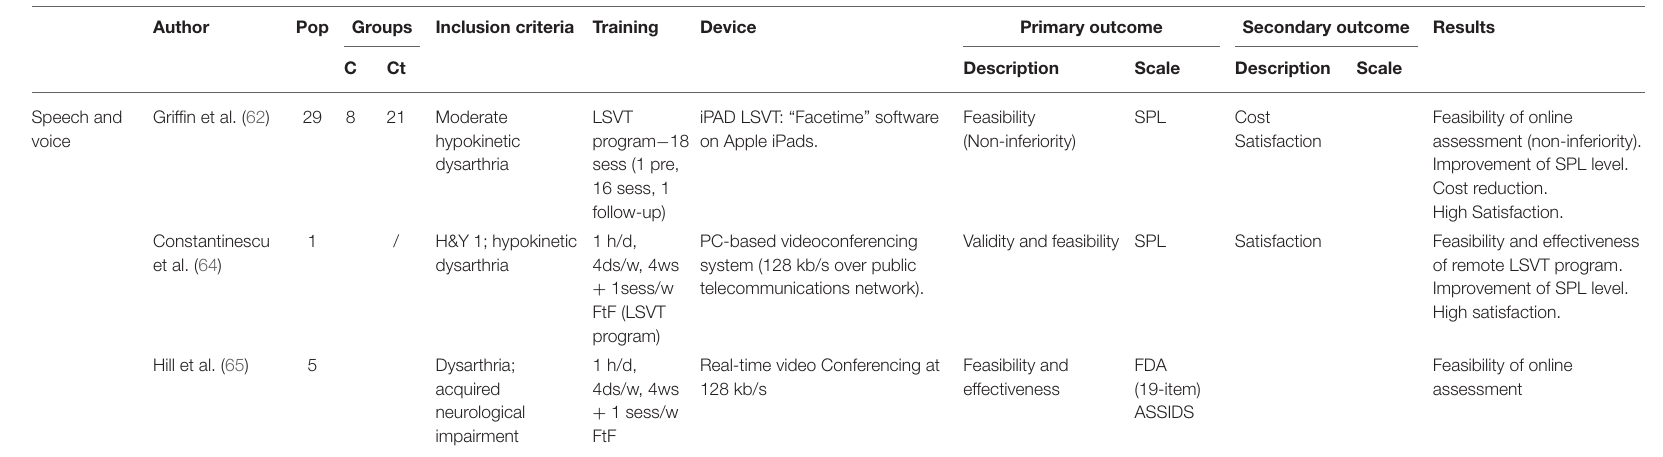
TABLE 7B | Description of the articles included which have “Speech and Voice” as primary